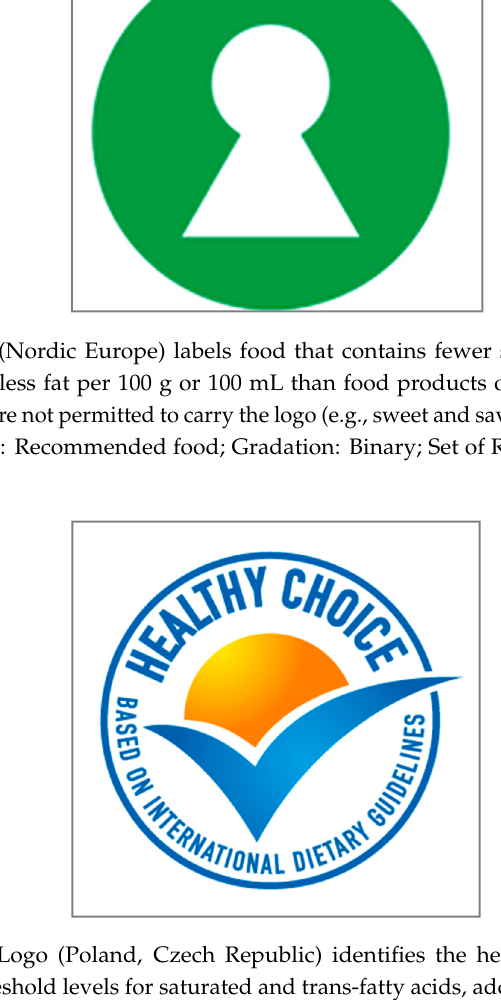
based on threshold levels for saturated and trans-fatty acids, added sugar, salt, dietary fibre, and/or energy, with category-specific cut-offs per 100 g or 100 mL. and / or energy, with category-specific cut-o ff s per 100 g or 100 mL. Directiveness: Food-Directive;